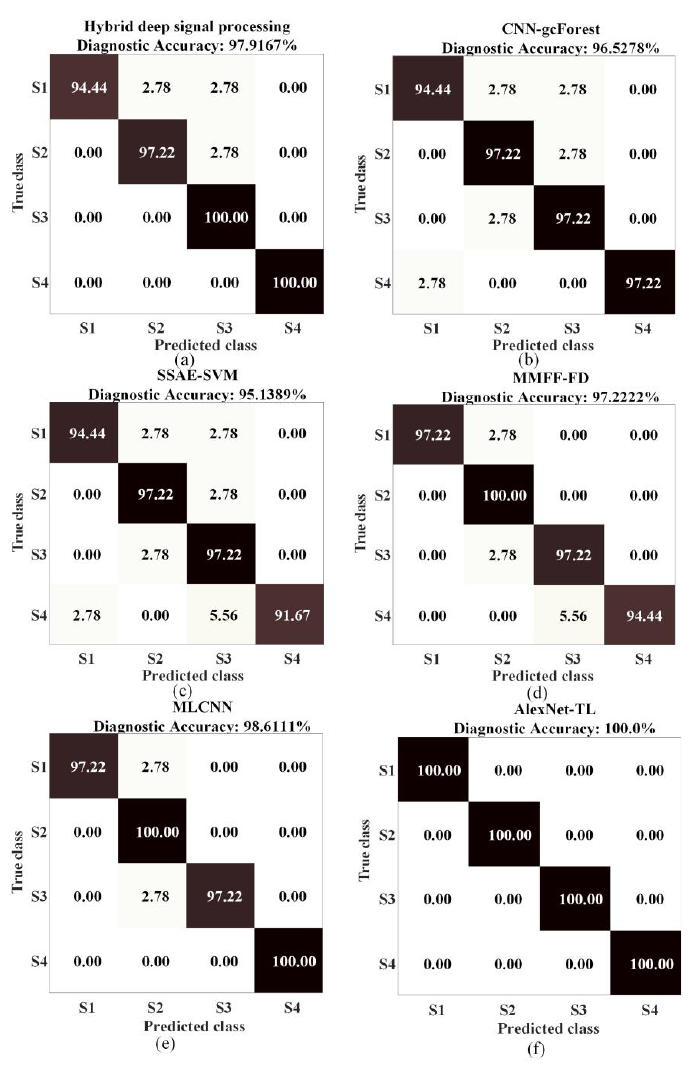
Figure 16. Diagnostic results of different diagnostic methods: ( a ) hybrid deep signal processing = 97.92%; ( b ) CNN − gcForest = 96.53%; ( c ) SSAE − SVM = 95.14%; ( d ) MMFF-FD = 97.22%; ( e ) MLCNN = 98.61%; ( f ) AlexNet − TL = 100.0%.